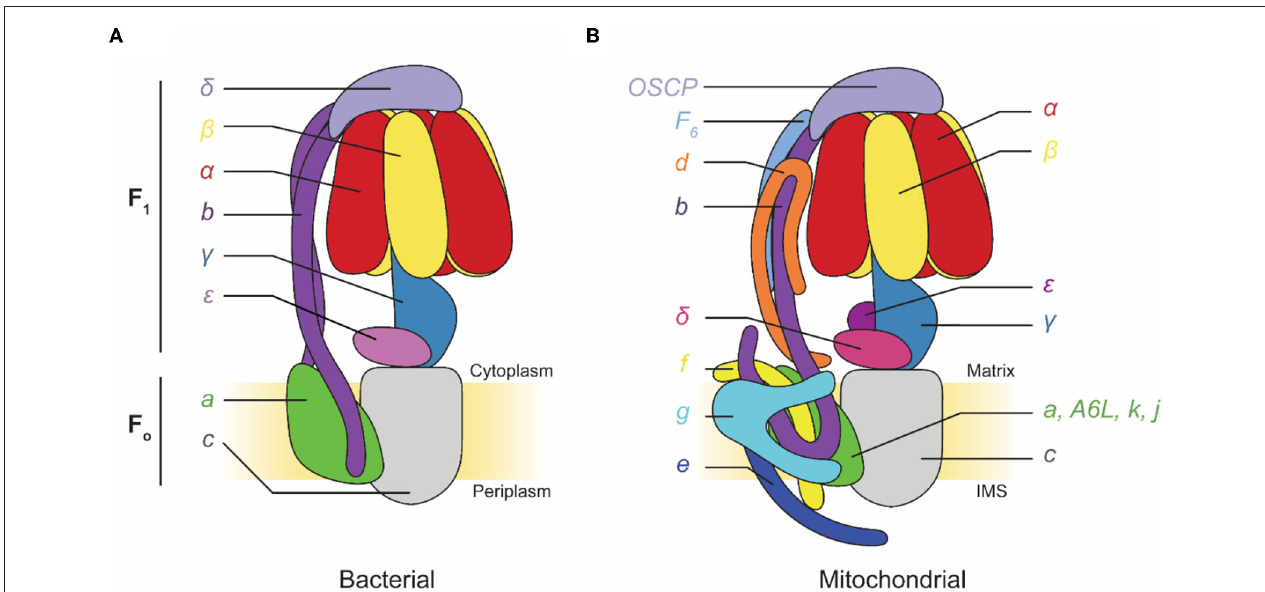
FIGURE 1 | Subunit composition of commonly studied adenosine triphosphate (ATP) synthases. (A) Cartoon of a bacterial ATP synthase. Based on Guo et al. (2019). (B) Cartoon of a mammalian mitochondrial ATP synthase. IMS, intermembrane